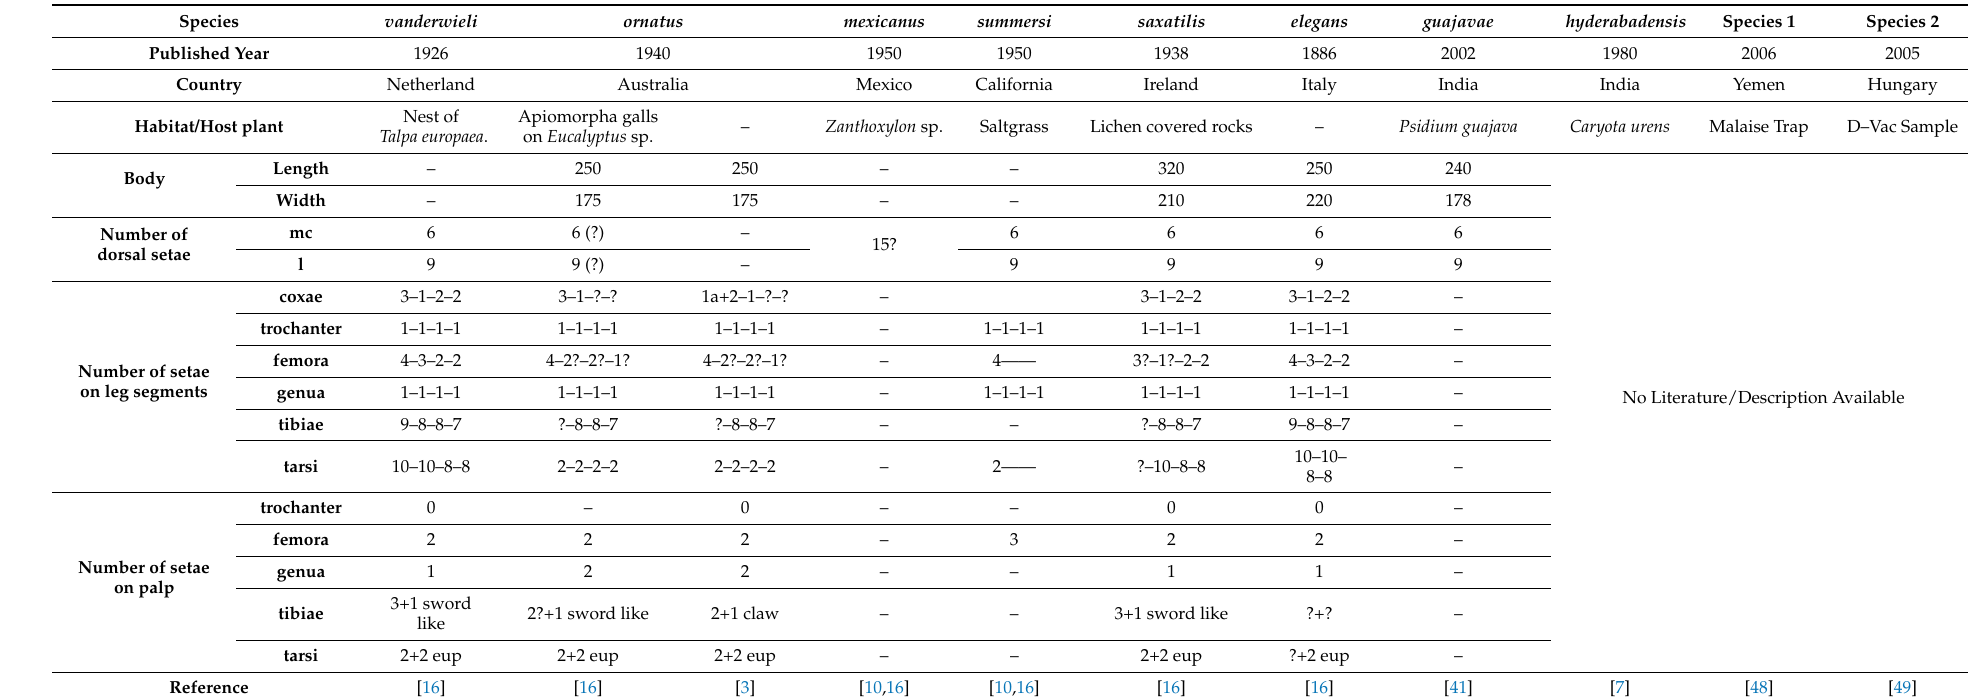
Table 2. Morphological characters of Neophyllobius species with incomplete